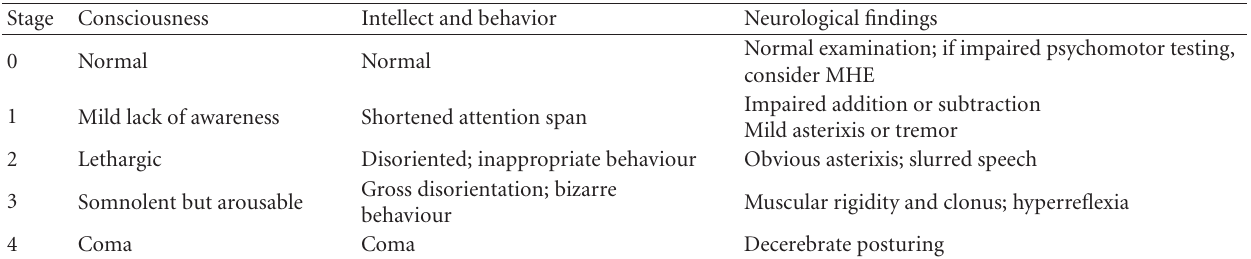
Table 2: West-Haven criteria for hepatic